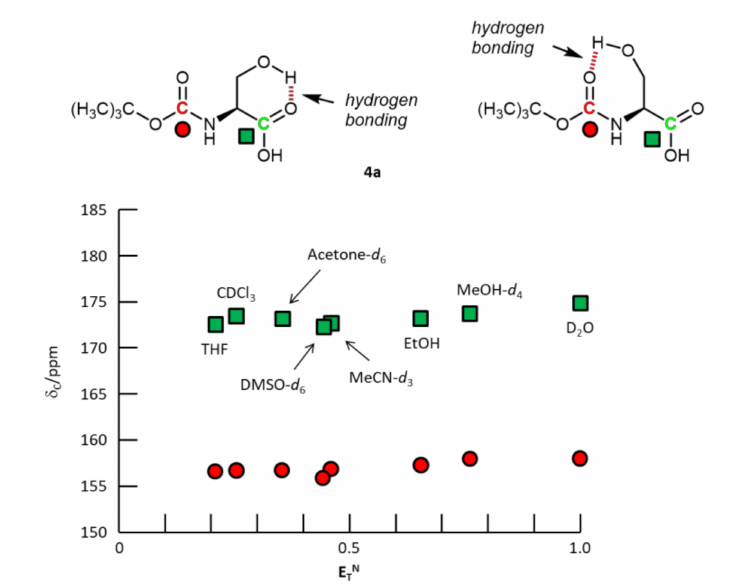
Figure 4. 13 C NMR chemical shifts of the carbonyl carbons of N -Boc-L-serine-OH 4a .